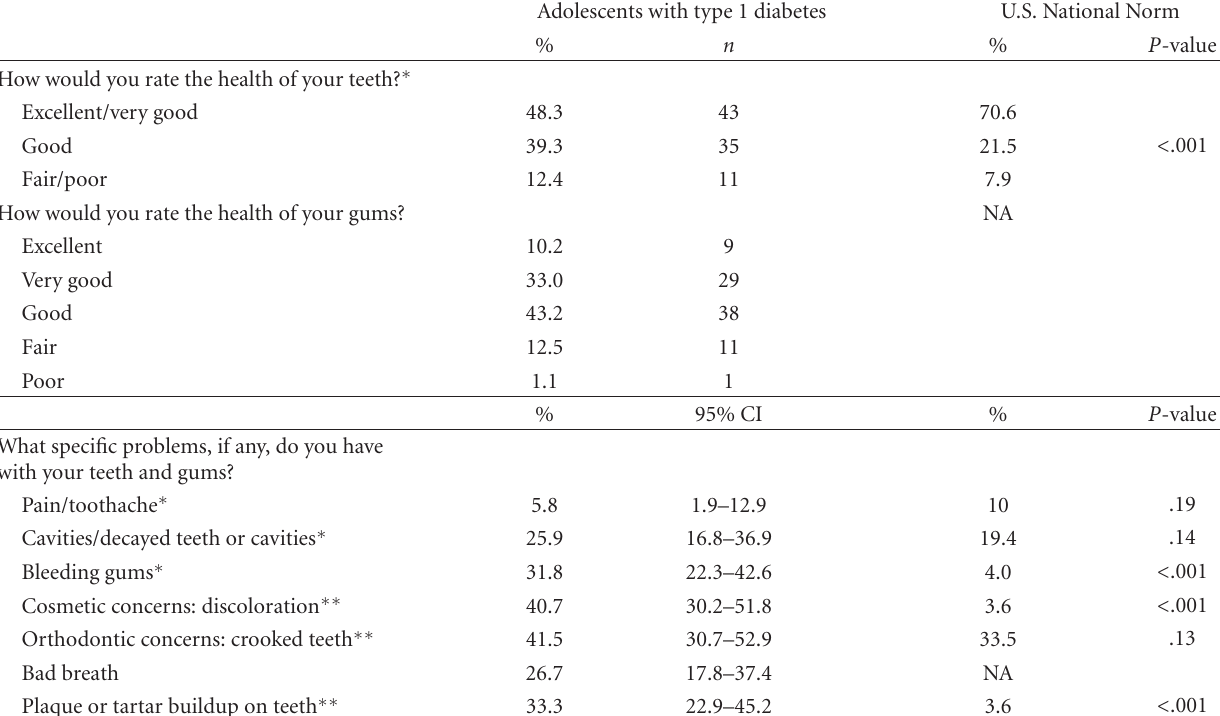
Table 2: Self-perception of oral health. Adolescents with type 1 diabetes